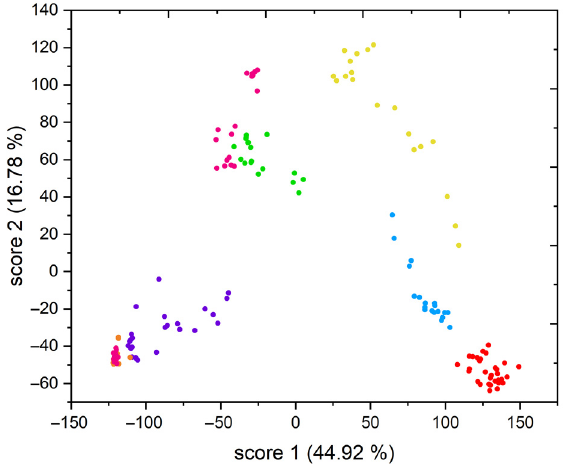
Figure 8. Score plot of PCA of all samples analyzed by LIBS on Echelle spectrometer (red—Cypriot mine 1, yellow—Cypriot mine 2, green—Cu 2 S in basalt, blue—CuFeS 2 in basalt, purple—Polish mine, orange—Cu 2 S in schist, pink—CuFeS 2 in schist). Table 4. Different regression models with coefficients of determination (R 2 ) and root mean square error (RMSE) of the regression and validation using the field samples from Poland measured on the Echelle spectrometer after the elimination of outliers by the ROBPCA